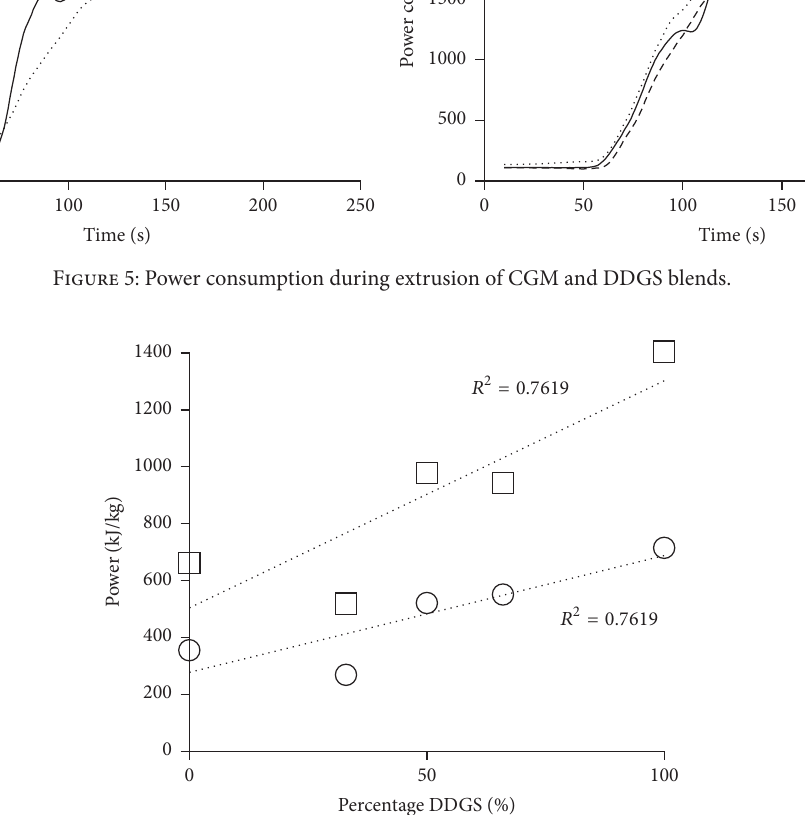
Figure 6: Power consumption during extrusion of CGM and DGS as a function of DDGS content. ◻ : peak power; I : average power.